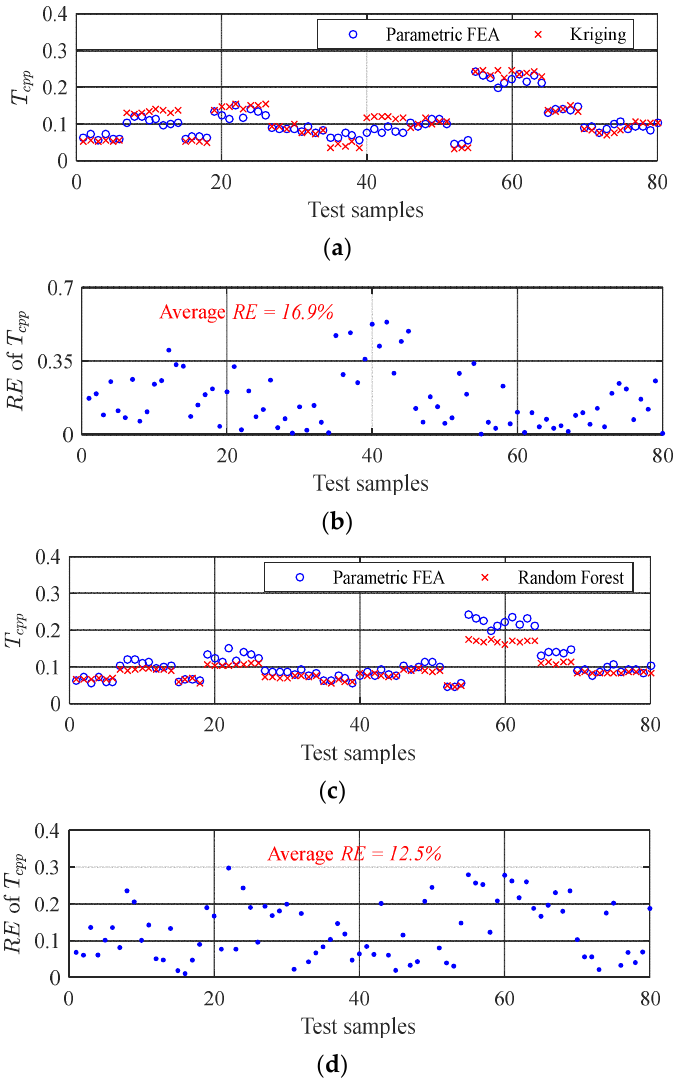
Figure 15. Single conventional approximate modeling: ( a ) Kriging approximate modeling; ( b ) the RE of Kriging; ( c ) random forest approximate modeling; ( d ) the average RE of random forest.